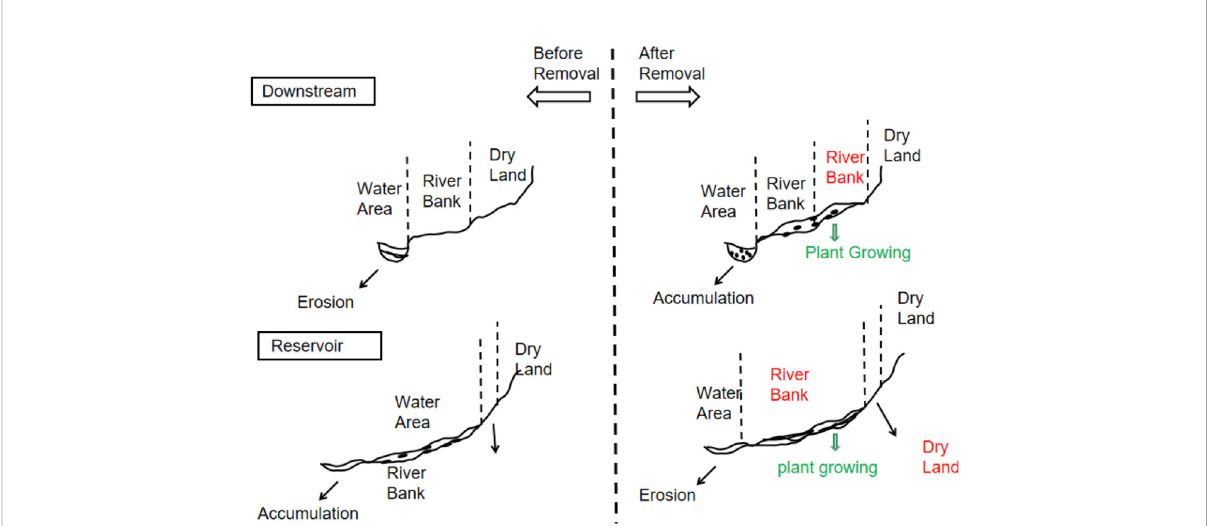
FIGURE 7 Two possible outcomes of dam removal. The red words in the fi gure show the cross-section areas that have changed after the dam removal, the green words show the riparian plant zone, and black particles represent sediment and